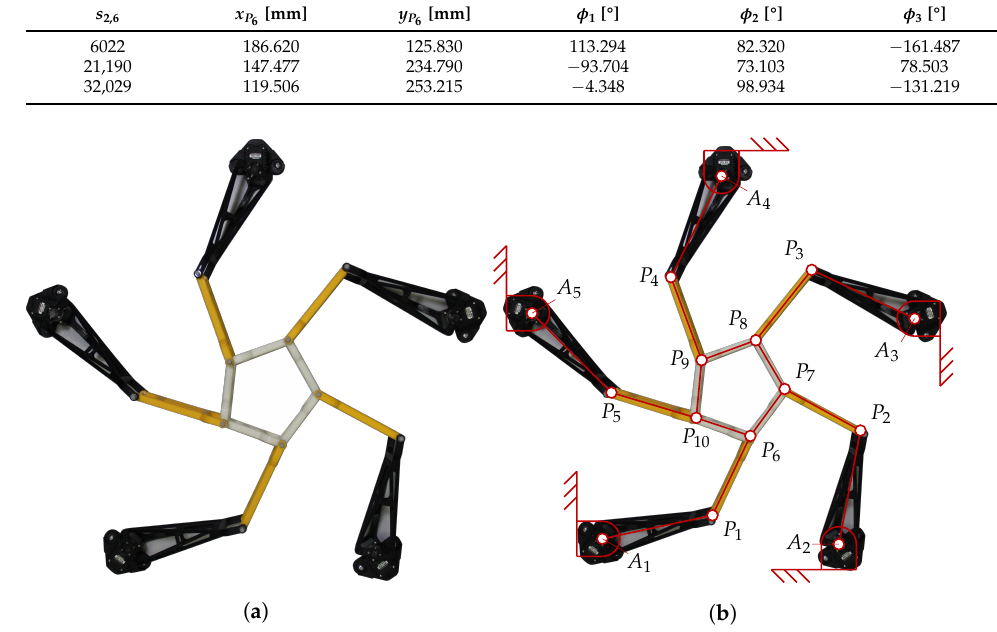
Figure 6. ( a ) The 5-RRR prototype developed at IRI; ( b ) its corresponding